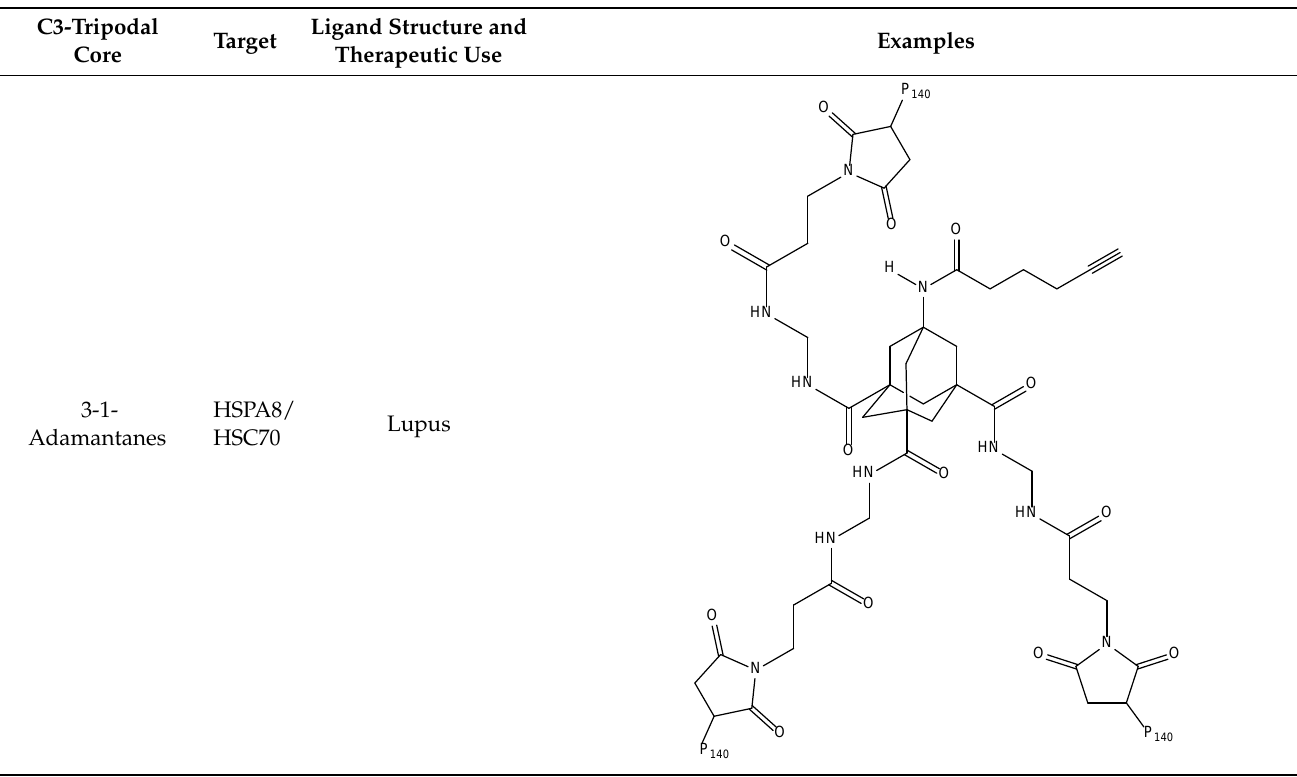
Table 1. Examples of C3-symmetric ligands and their